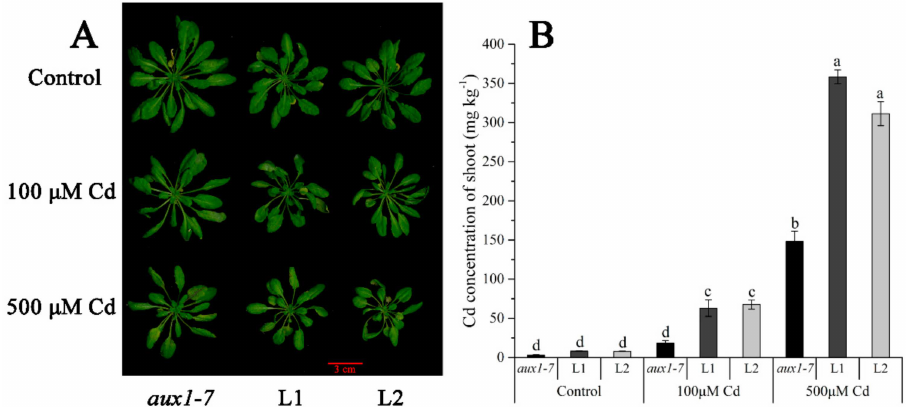
Figure 6. The Cd tolerance experiment on plates of LmAUX1 . LmAUX1 was transformed into the Arabidopsis thaliana aux1-7 mutant with the CaMV35S promoter, and two lines (L1 and L2) were used for the experiment. ( A ) Phenotype of plants grown in 1 / 2 MS medium with and without 50 µ M Cd for 4–5 d. Scale bar = 1 cm. ( B ) Relative length of root elongation. Data are means ± SE (n ≥ 15); di ff erent letters above the bars were significantly di ff erent at p < 0.05 (Duncan’s test).